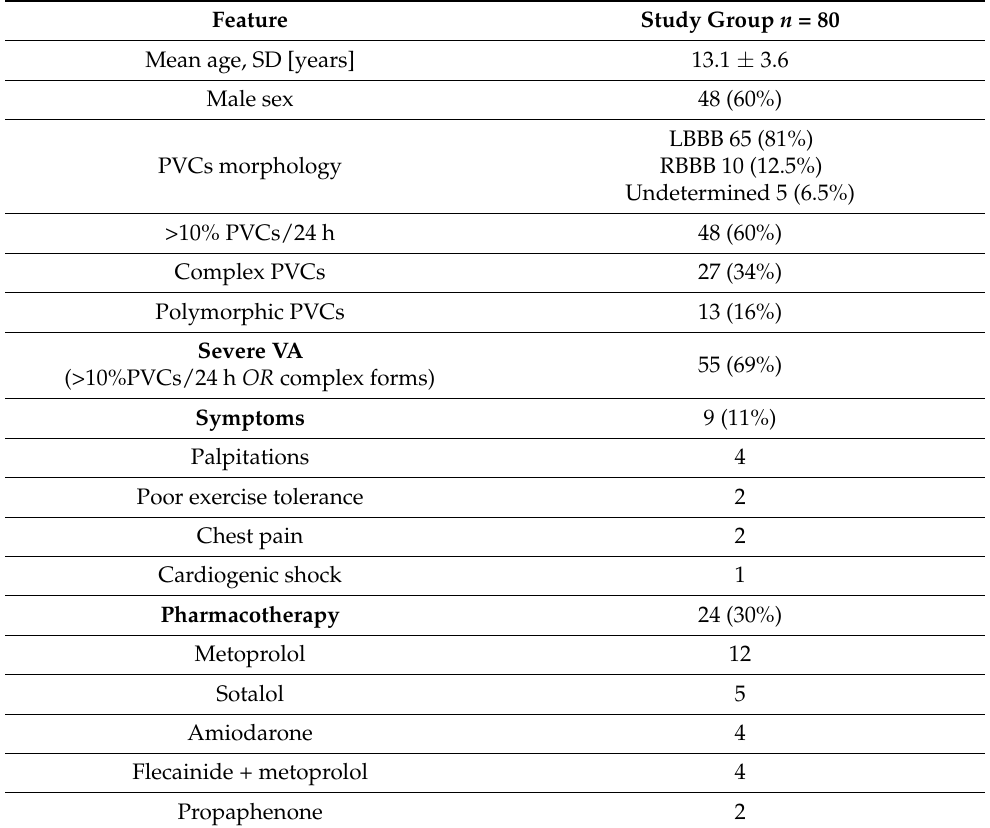
Table 1. Patients’ baseline